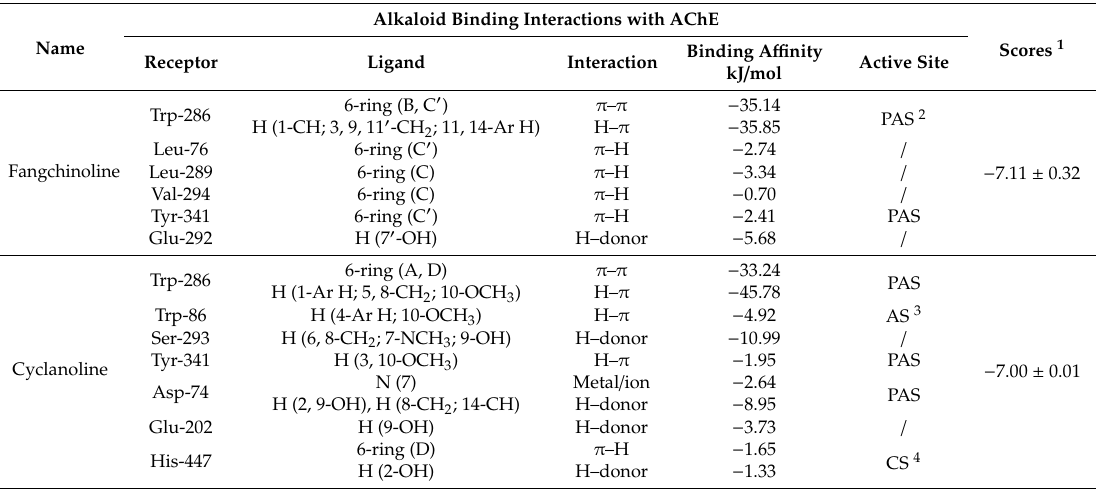
Table 2. The binding residues of fangchinoline and cyclanoline with the AChE active